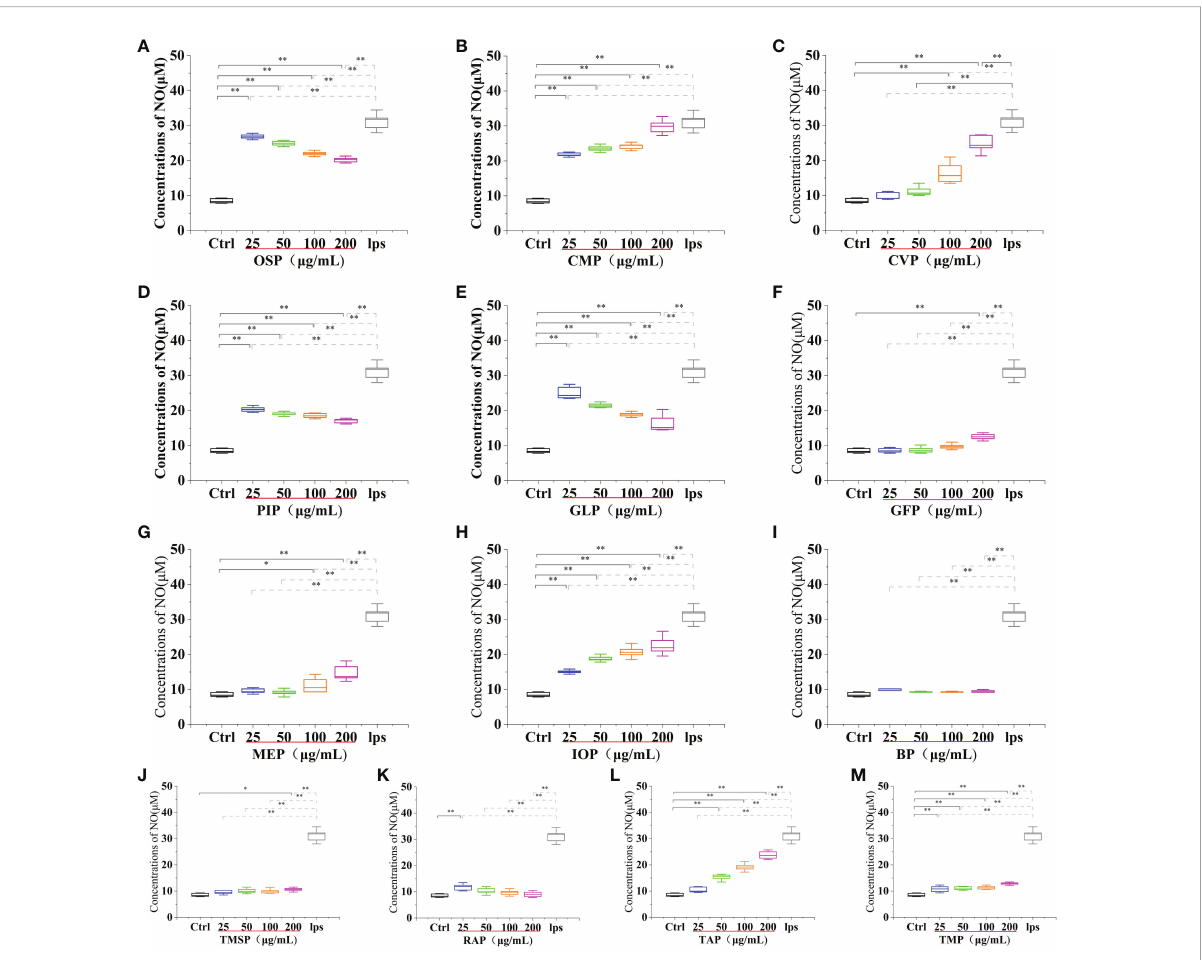
FIGURE 7 Effect of different edible mushroom protein treatments on NO production in RAW 264.7 cells. OSP (A) , CMP (B) , CVP (C) , PIP (D) . GLP (E) , GFP (F) . MEP (G) , IOP (H) , BP (I) , TMSP (J) , RAP (K) , TAP (L) and TMP (M) on RAW 264.7 cells for NO production. Data are expressed as mean ± SD (n = 5). *P < 0.05 and **P < 0.01 compared to the control